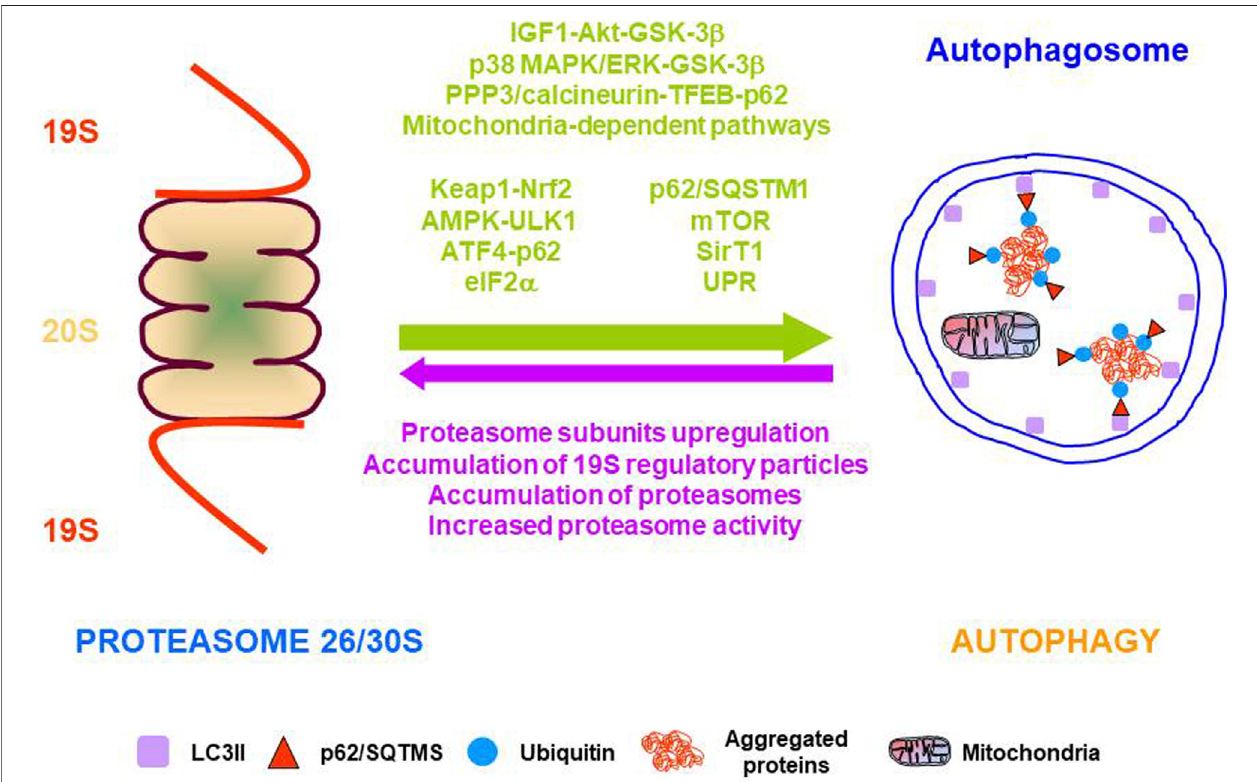
FIGURE3| Molecular pathways, proteins, andmechanismsinvolvedinthefunctionalcooperationbetweenthetwomajorproteolytic systems.Arrowsindicate the functional cooperation from proteasome to autophagy (green) and from autophagy to proteasome (purple).